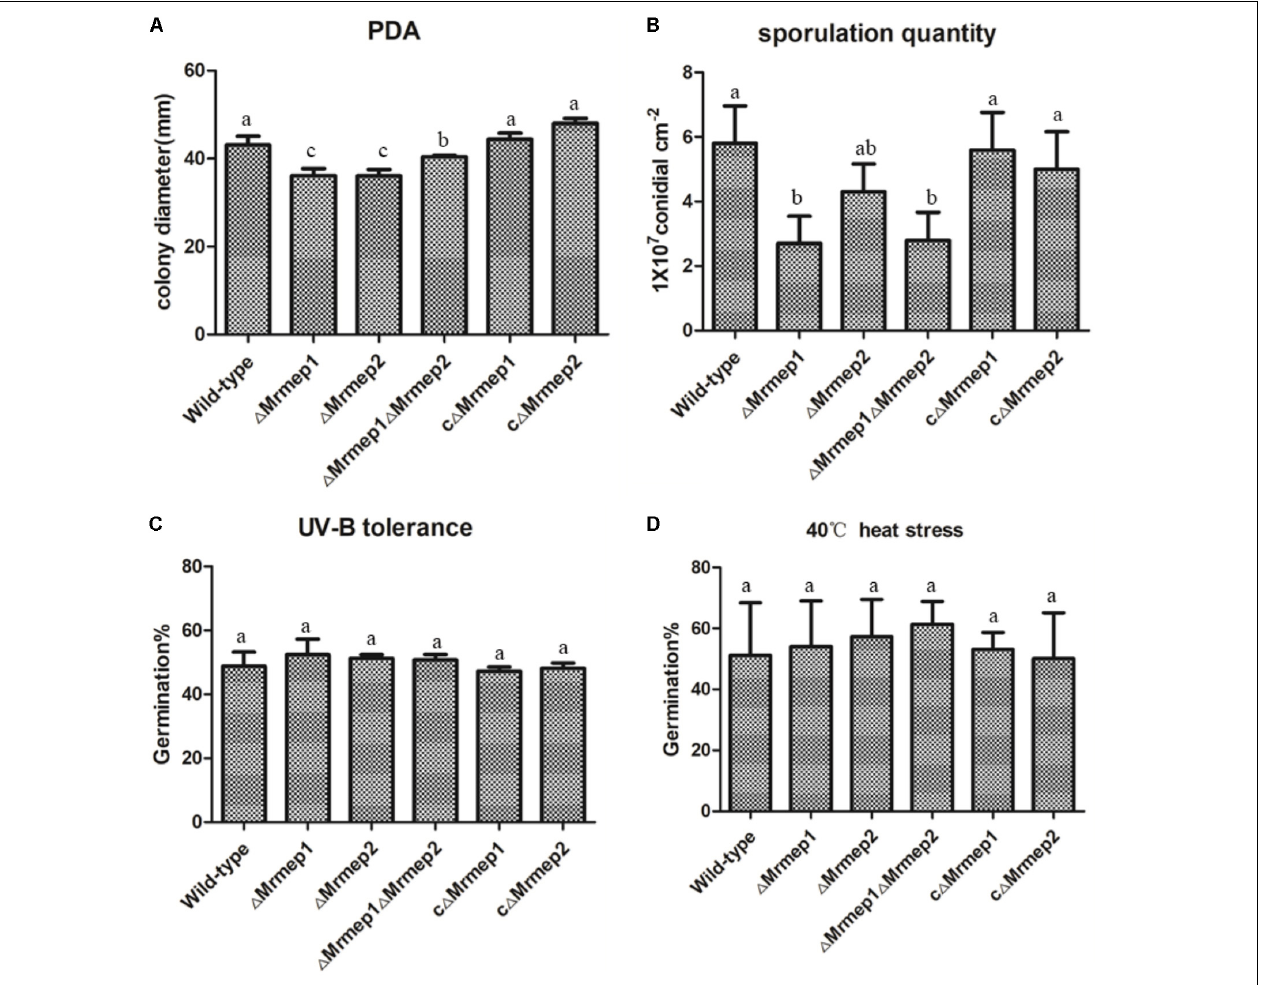
FIGURE 3 | Wild-type (WT) and mutant strain growth rates and germination in PDA as well as heat and UV-B stress tolerance. (A) WT and mutant strains were spot inoculated onto PDA plates. (B) Sporulation quantity of the strains at 14 days. (C) WT and mutant strains were cultivated at 40 ◦ C under heat stress for 60 min. (D) WT and mutant strains were cultivated under UV-B irradiation for 90